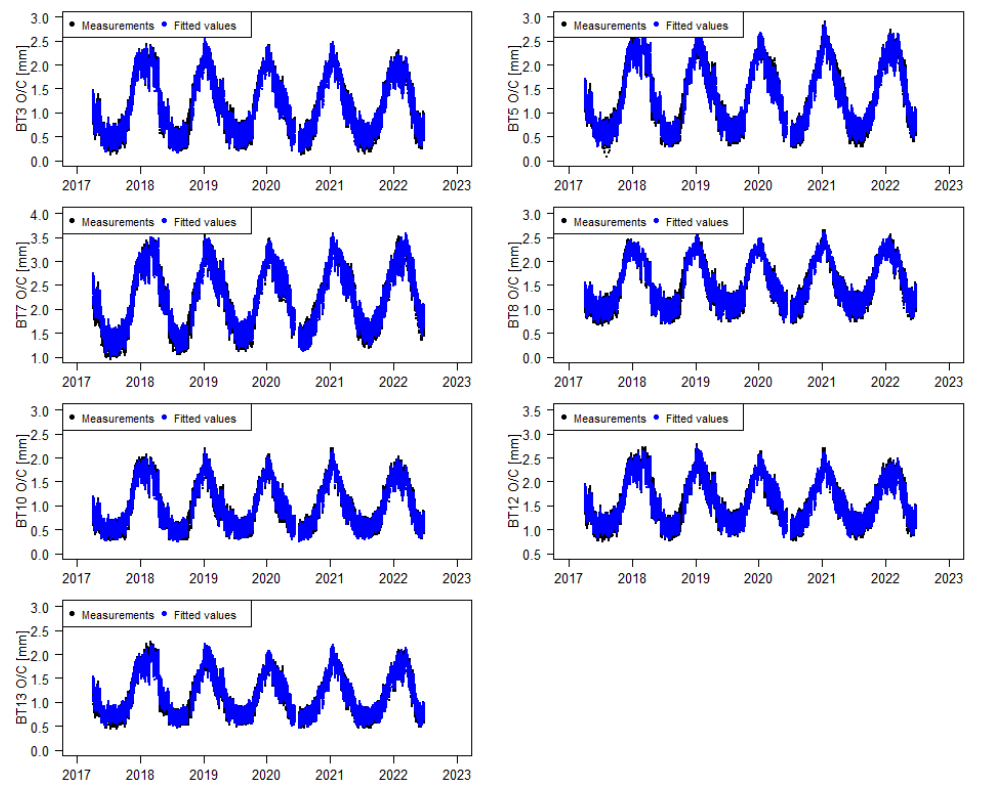
Figure 12. Time series of the fitted values and recorded values for the movements measured through 3D jointmeters.